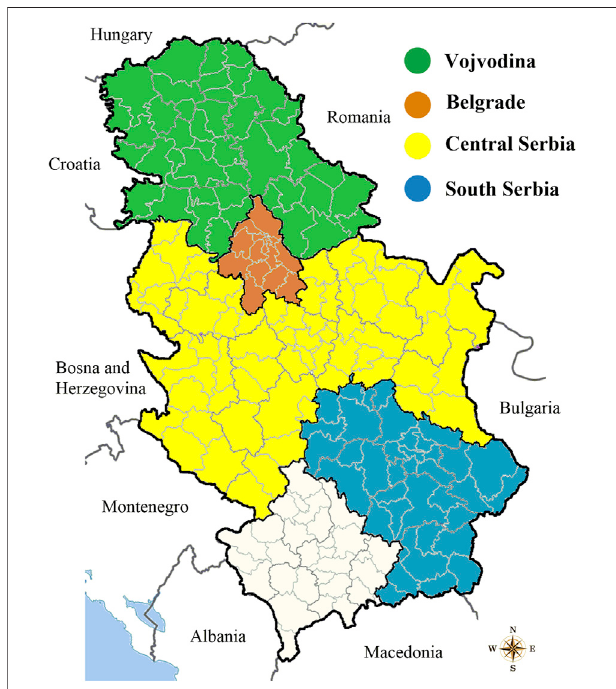
FIGURE 1 | Geographical regions of Serbia for provision of wine